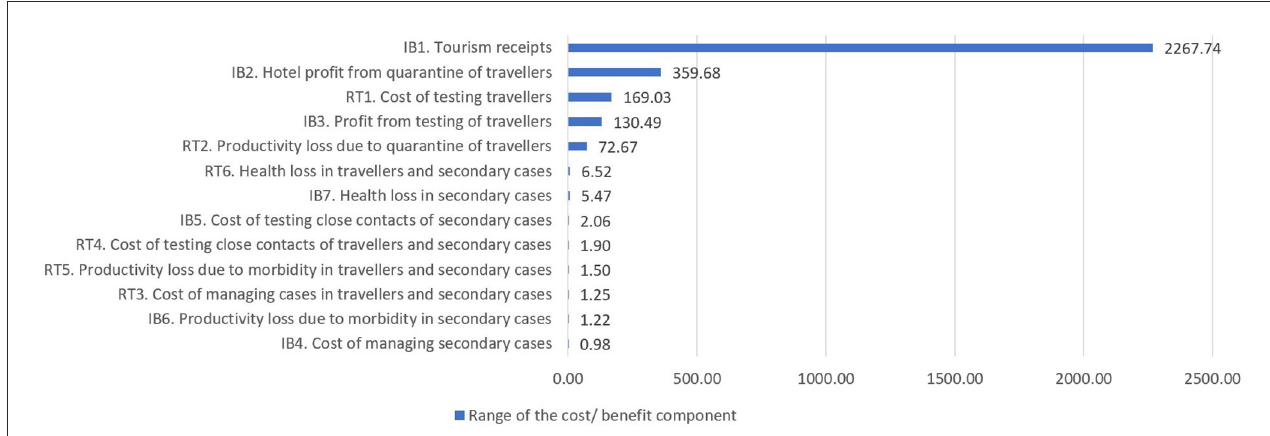
FIGURE1 Range of cost/benefit components in the combined analysis (not vaccine differentiated). Cost/benefit components (corresponding to Supplementary Table A.7 in Supplementary material 3) are sorted from largest range to smallest range. Range is calculated as the difference between the highest and lowest instances of the 13 cost/benefit components across all policy options. The larger the range of a cost/benefit component, the more it contributes to driving which policy option has higher NMB or INB. IB, inbound traveler; RO, returning traveler; COVID-19, coronavirus disease 2019; NMB, net monetary benefit; INB, incremental net benefit, compared to pre-opening